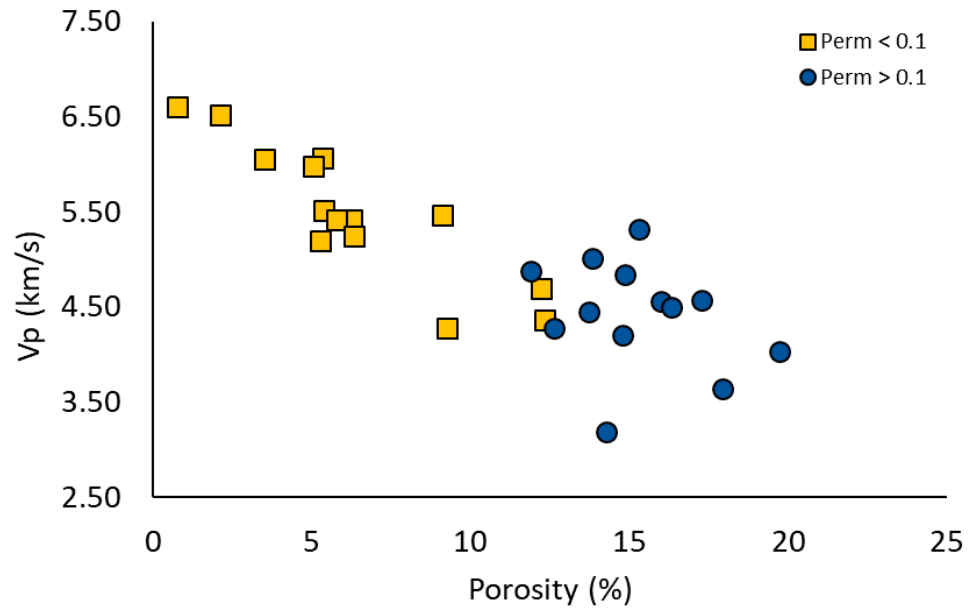
Figure 16. Velocity–porosity relationship with permeability values superimposed. Most of the samples with higher permeabilities (>0.1 mD) lie below the line of 5 km/s velocity.